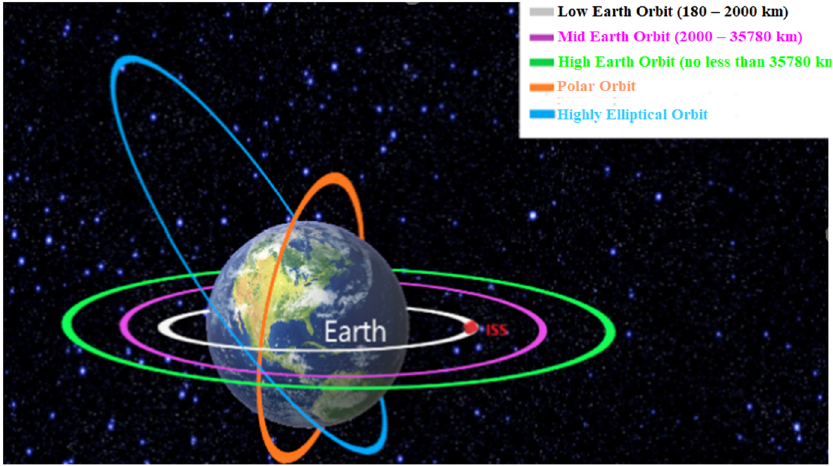
Figure 2. Altitude classifications for geocentric orbits.